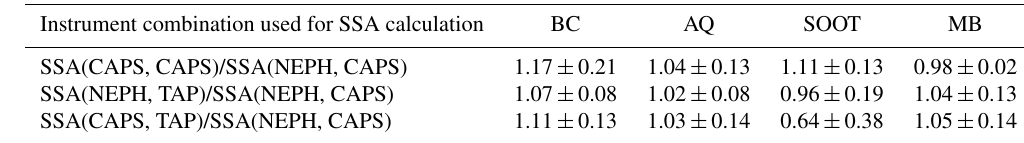
Table 11. Ensemble instrument-to-instrument measurement ratio averages and standard deviations for different instrument combinations used to derive SSA values at 450nm wavelength using SSA(NEPH, CAPS) as a reference. Instrument combination used for SSA calculation